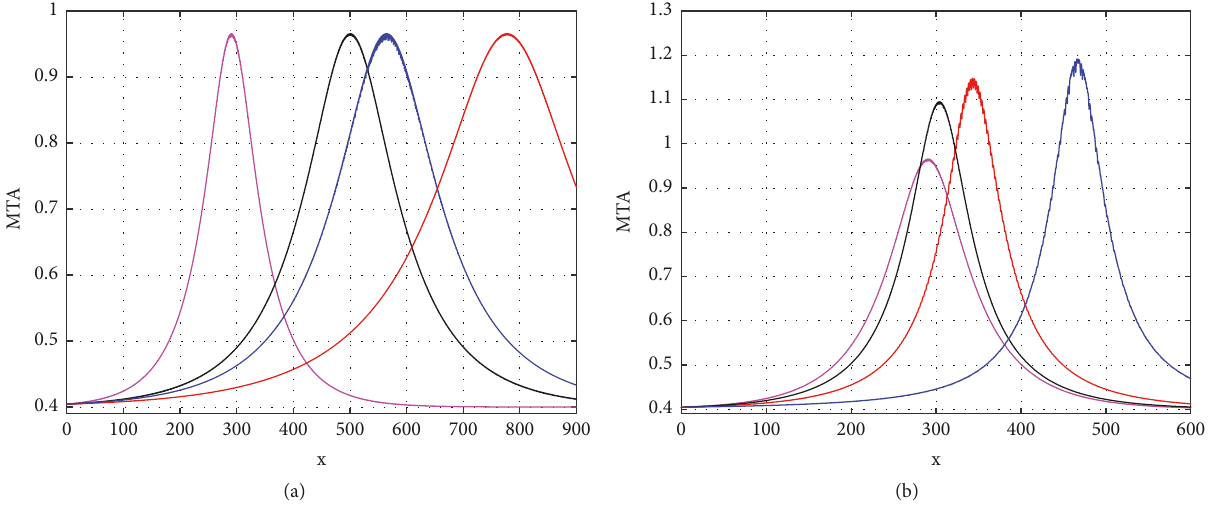
̃ 𝑘 = 0.6 ̃ 𝑘 = 0.7 ̃ 𝑘 = 0.9186 ̃ 𝑘 = 3 (magenta), (black), (red), and (blue) with